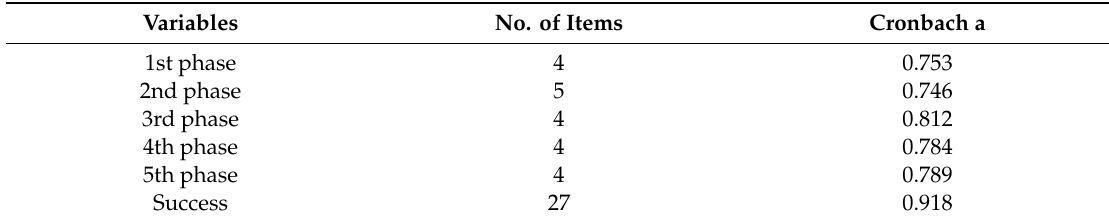
Table 3. Reliability analysis of the questionnaire